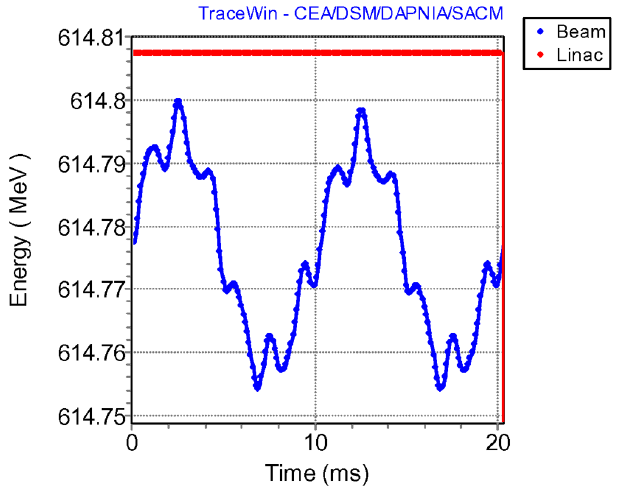
1 In the full following document, all the charts will always show these two curves: red (cid:2) static case; blue (cid:2) transient case (i.e. with cavity